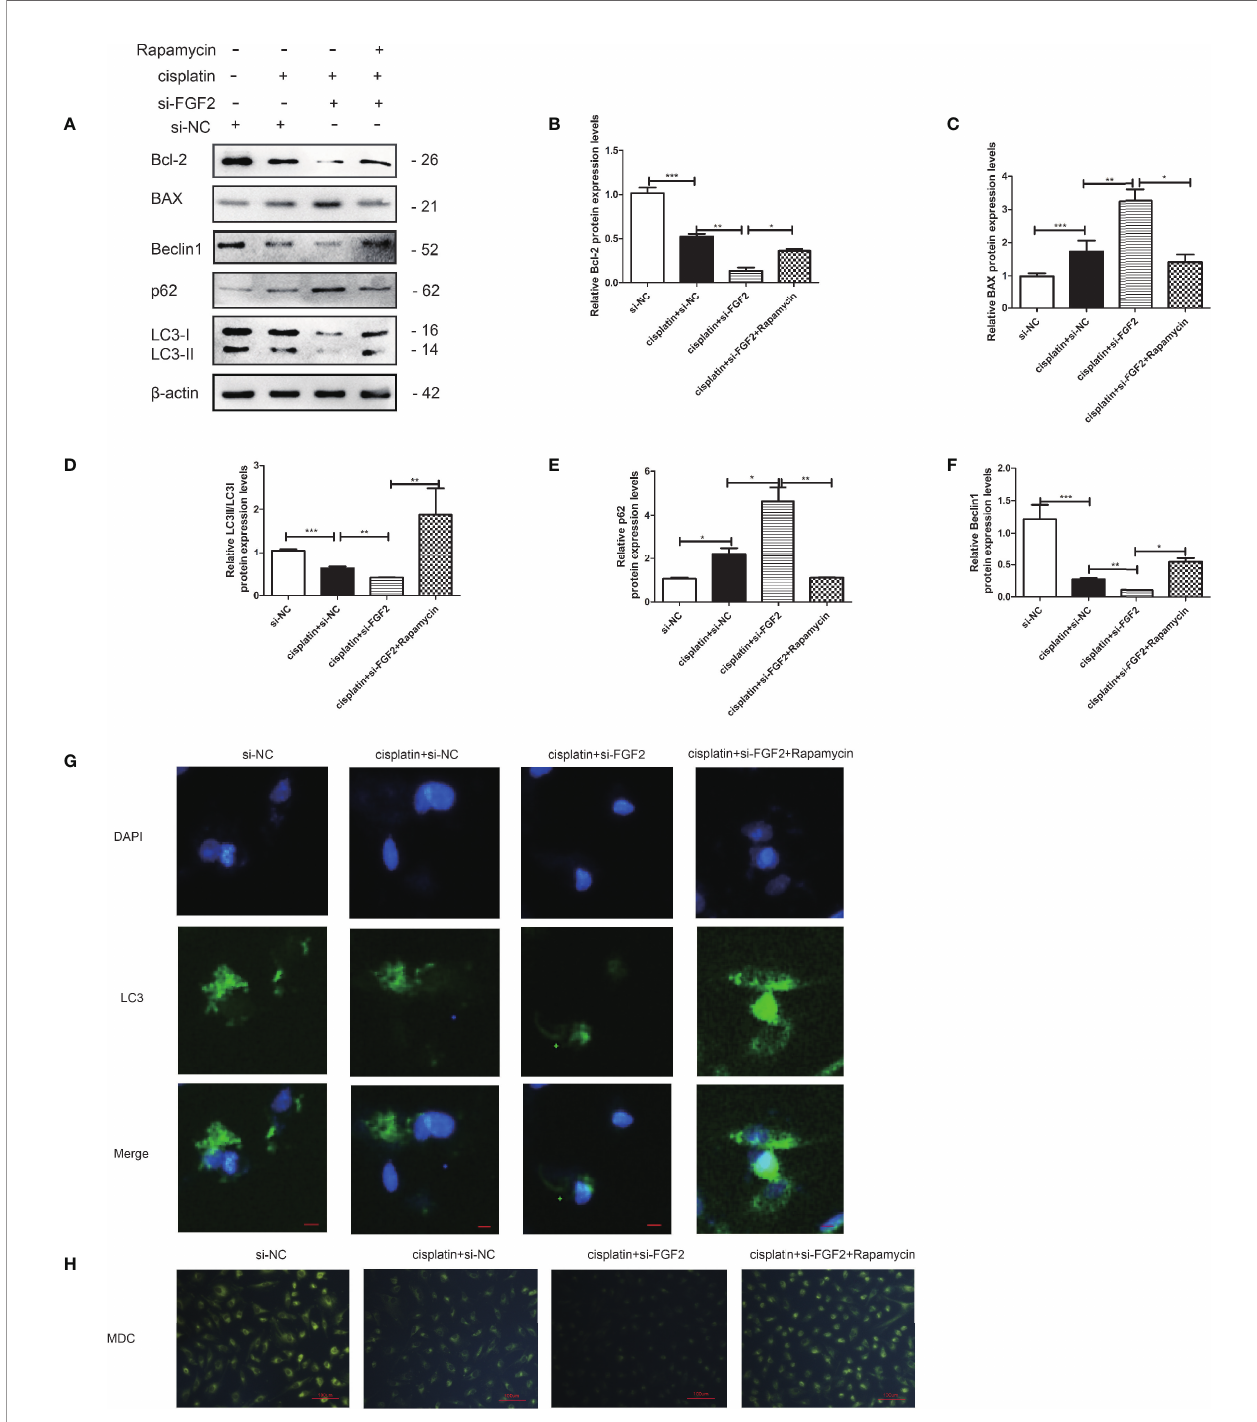
FIGURE 5 | Activation of autophagy by rapamycin attenuated the proapoptotic effects of si-FGF2 on injured KGN cells. After the injured KGN cells were transfected with si-FGF2 for 48 h, rapamycin was added and cultured for another 4 – 6 h. (A) The expression of Bcl-2, BAX, LC-3, Beclin1, and p62 was monitored by Western blot. Here, b -actin was used as a loading control. (B – F) Quantitative comparison of the different expression levels of Bcl-2, BAX, LC3, Beclin1, and p62. One-way ANOVA followed by Tukey ’ s multiple comparison test. The results were shown as mean ± SEM from three independent experiments ( a = 0.05, * P < 0.05, ** P < 0.01, *** P < 0.001). (G) Representative immuno fl uorescence image of GFP-LC3 puncta in KGN cells with different treatments (scale bar: 20 m m). (H) Representative images of KGN cells were treated with si-NC, si-NC plus cisplatin, cisplatin plus si-FGF2, and cisplatin plus si-FGF2 and rapamycin, and then cells were stained with MDC (scale bar: 100 m